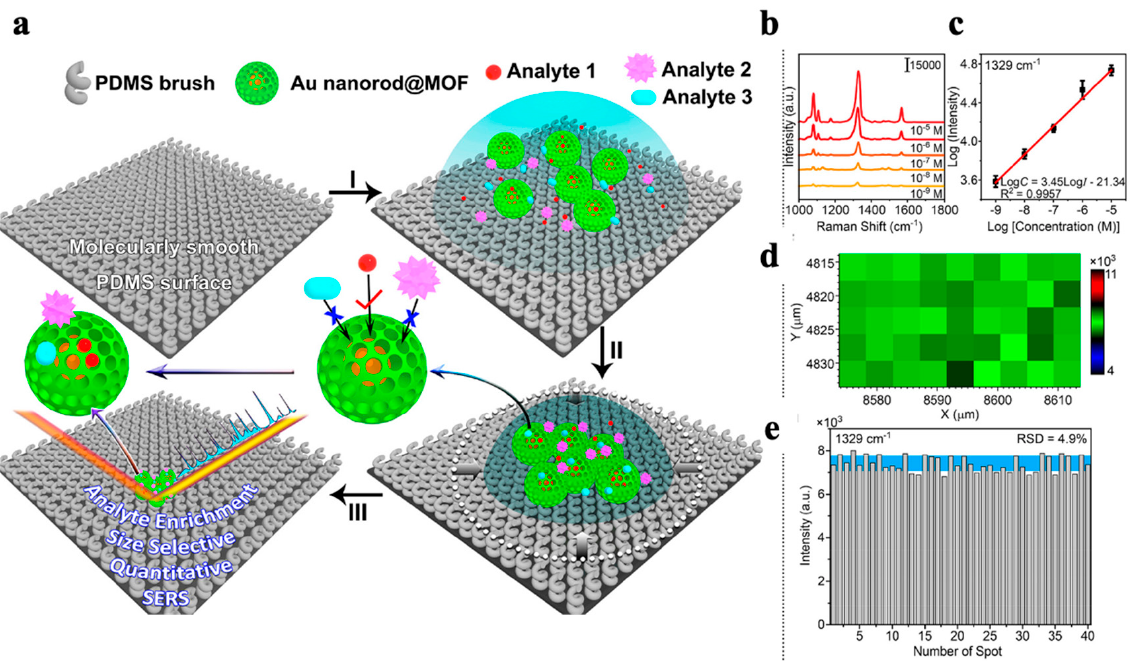
Figure 9. ( a ) Schematic illustration of the working principle of the AEF-SERS platform, showing application of the test solution (I), the enrichment and sieving effect (II), and the formation of analyte-SERS substrate aggregates (III) for selective and sensitive quantification of the analyte. ( b ) SERS spectra of 4-NBT at different concentrations using AuNR@ZIF-8 TRDs on the PDMS brush surface. ( c ) The calibration curve of 4-NBT at 1329 cm − 1 . ( d ) SERS mapping of 10 nM 4-NBT at 1329 cm − 1 using AuNR@ZIF-8 TRDs. ( e ) Intensity variations at 1329 cm − 1 from randomly chosen 40 SERS spectra using AuNR@ZIF-8 TRDs [75]. Copyright 2020, American Chemical